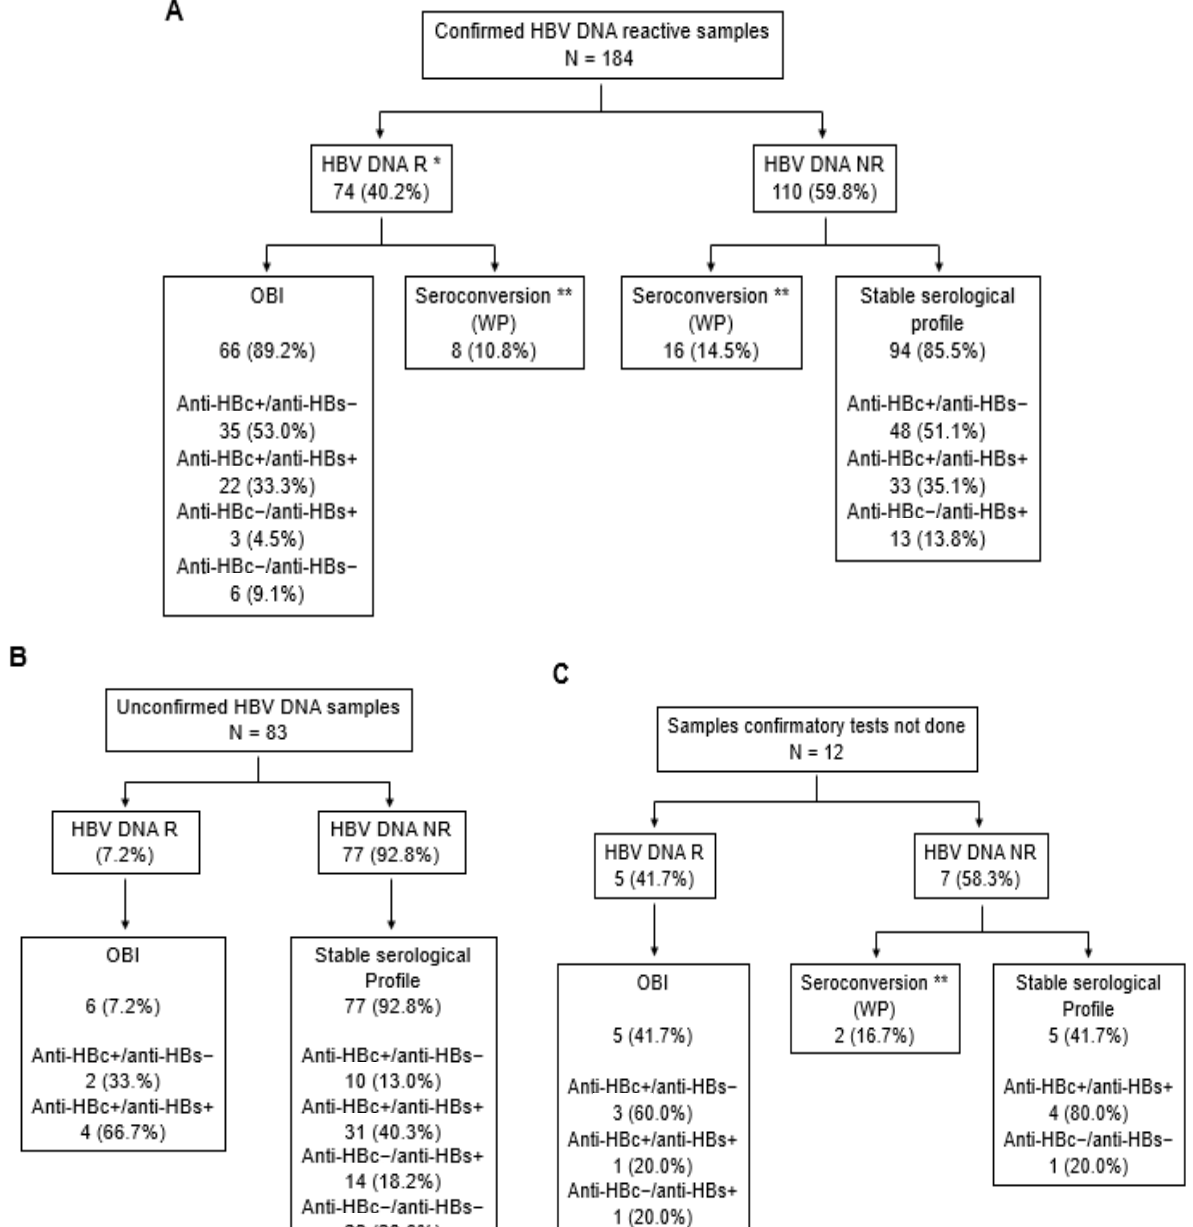
Figure 4. HBV follow-up testing of donors confirmed ( A ) and unconfirmed ( B ) HBV DNA reactive, and donors not tested for confirmation ( C ). * including 31 donors with transiently detectable HBV DNA; ** WP identified by evidence of HBsAg and/or anti-HBc seroconversion.